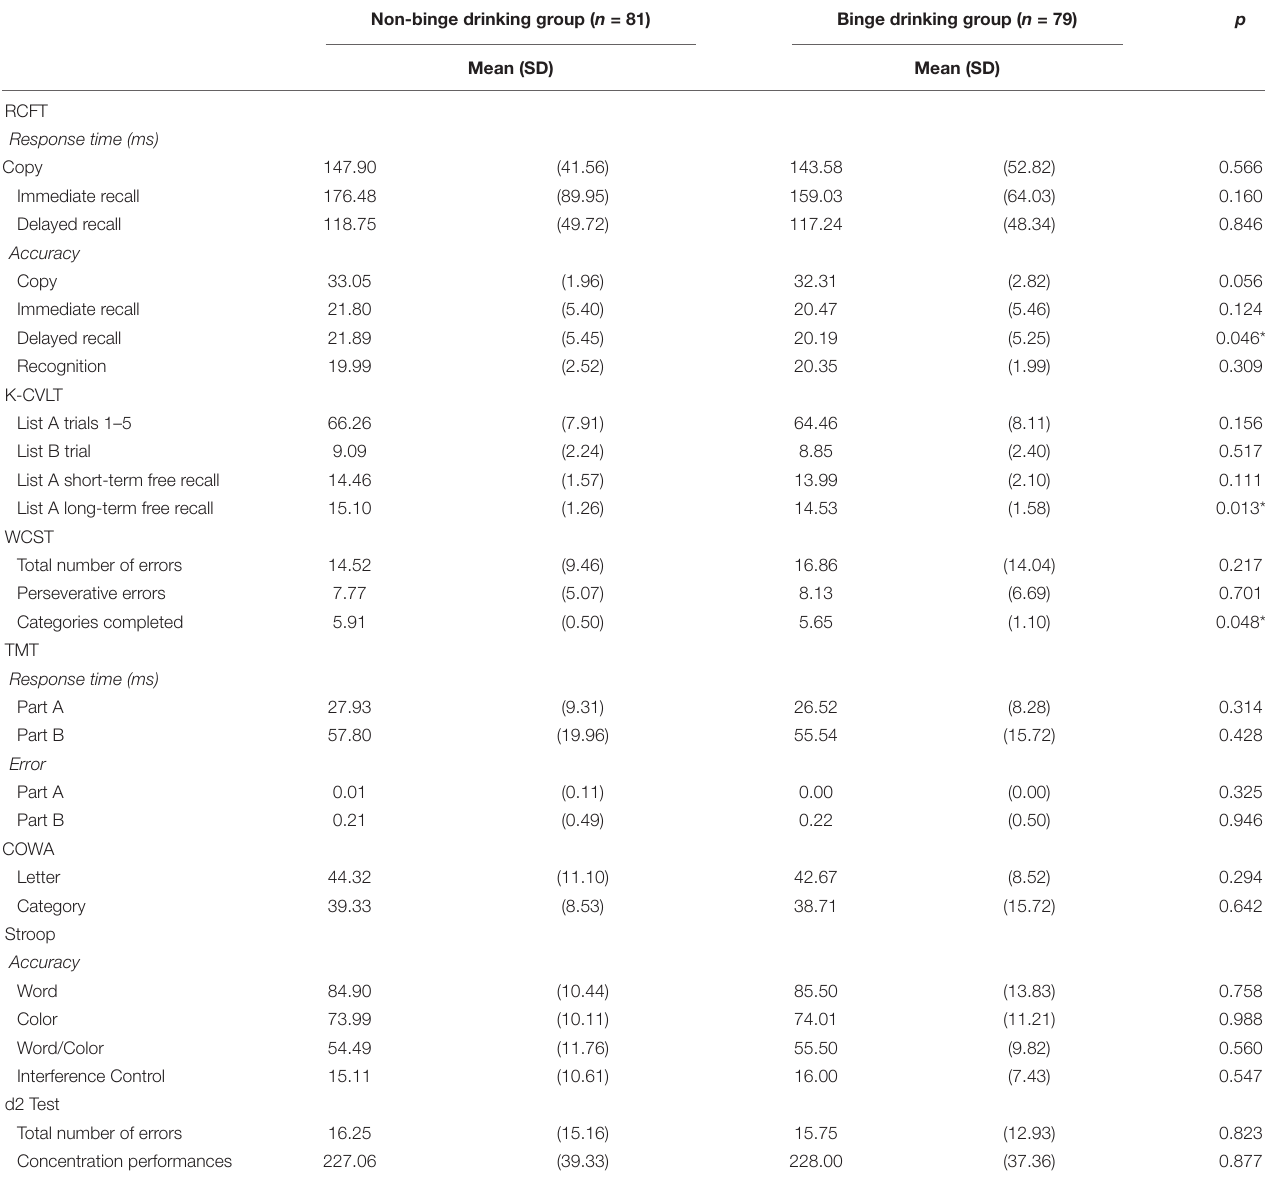
TABLE 2 | Neuropsychological performance of the binge drinking and non-binge drinking groups. Non-binge drinking group ( n = 81) Binge drinking group ( n = 79)